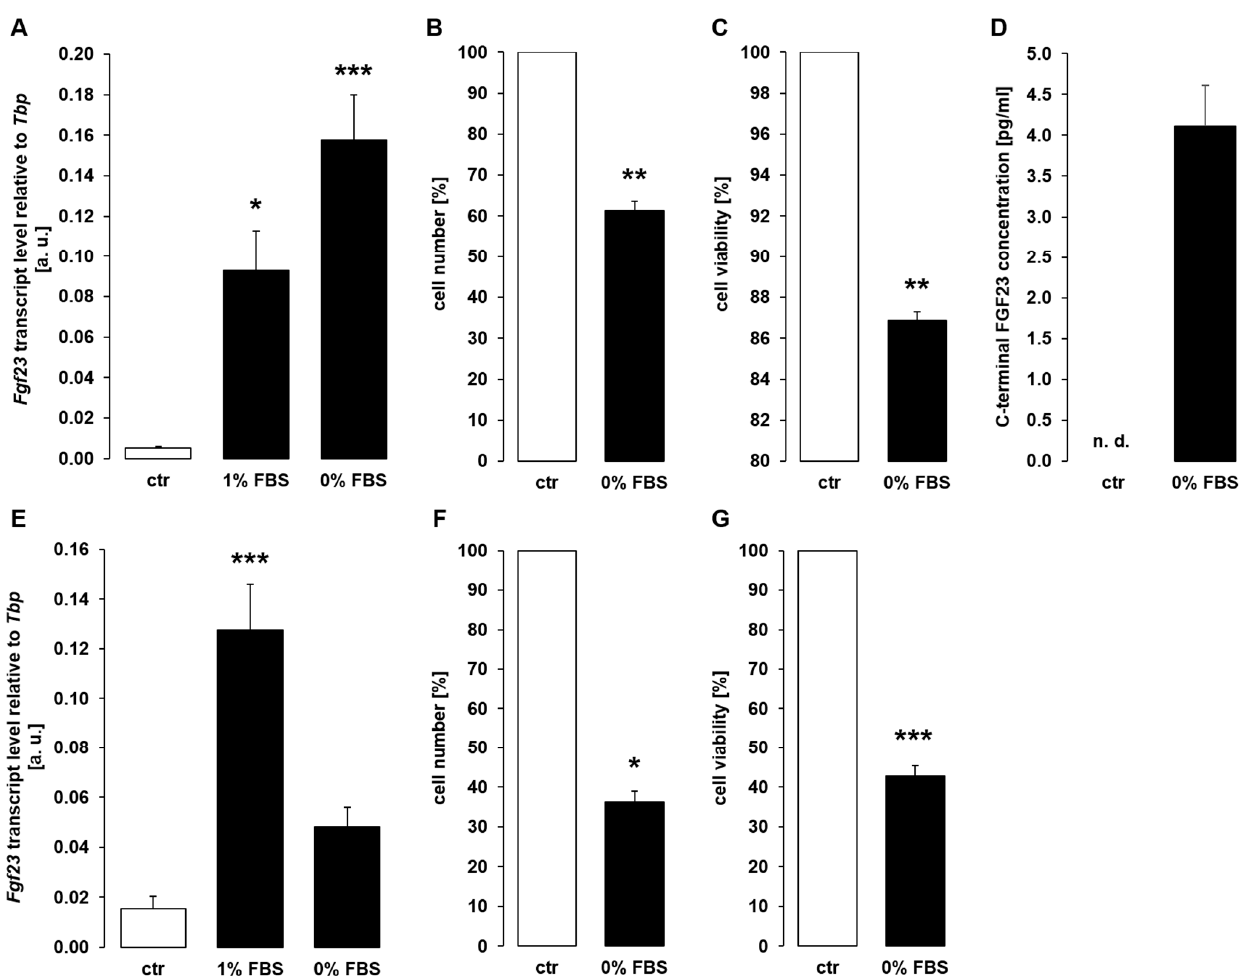
Figure 4. Serum depletion induced Fgf23 expression and secretion in osteoblast ‐ like UMR106 cells.